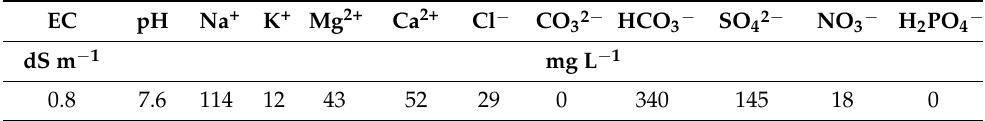
Table A1. Analytical determinations of the irrigation water.